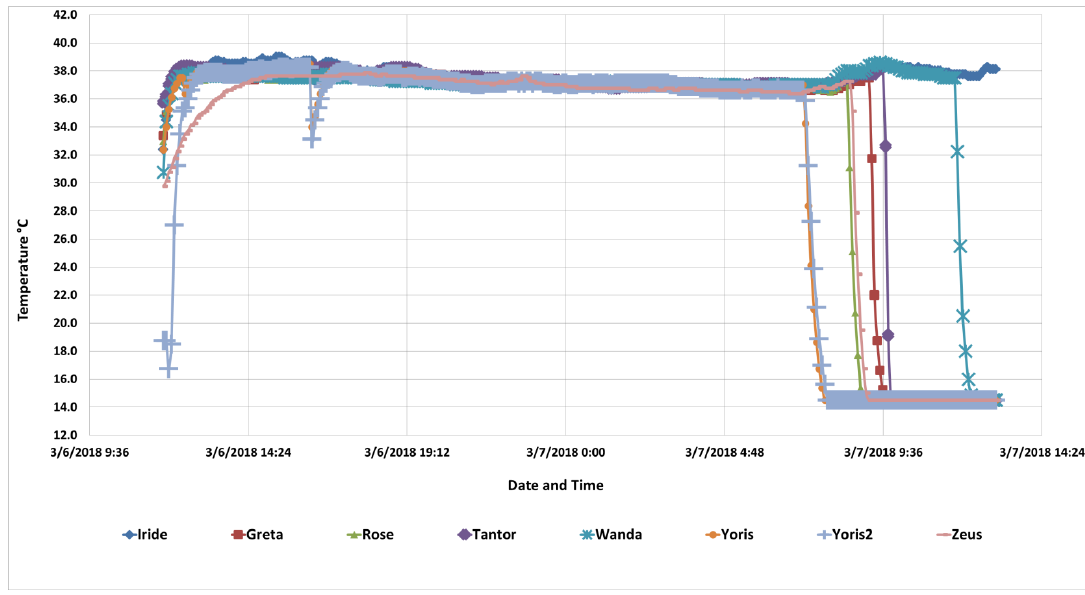
Figure 5. Body temperature data for the seven lions (two loggers were recovered for Yoris) commencing as the loggers were fed to the lions at noon, and terminating at 13:00 the next day. The thick blue and teal lines are because multiple temperatures were essentially identical. Iride’s body temperature data (enhanced black line) that extended until her logger was expelled at 14:50 is not shown after